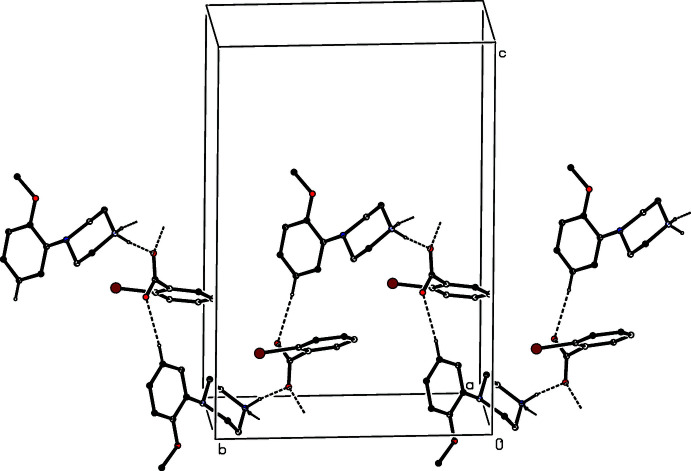
Part of the crystal structure of compound (VI) showing the formation of a chain running parallel to [010], in which ion pairs are linked by alternating N—H⋯O and C—H⋯O hydrogen bonds. Hydrogen bonds are drawn as dashed lines and, for the sake of clarity, the H atoms not involved in the motif shown have been omitted.